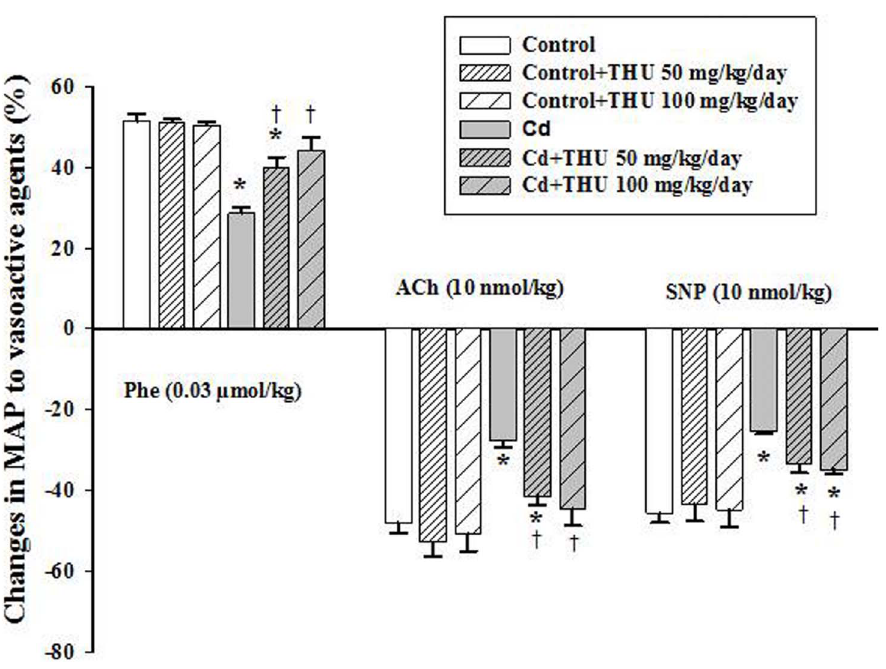
Fig. 1. Effect of THU on alteration of blood pressure in response to vasoactive agents in all experimental groups. Change in mean arterial pressure (MAP) was calculated as a percentage of baseline MAP after challenge with each vasoactive agent. Results are expressed as mean ¡ SEM., n 5 8–10/group. * P , 0.05 compared with untreated control group; { P , 0.05 compared with Cd control